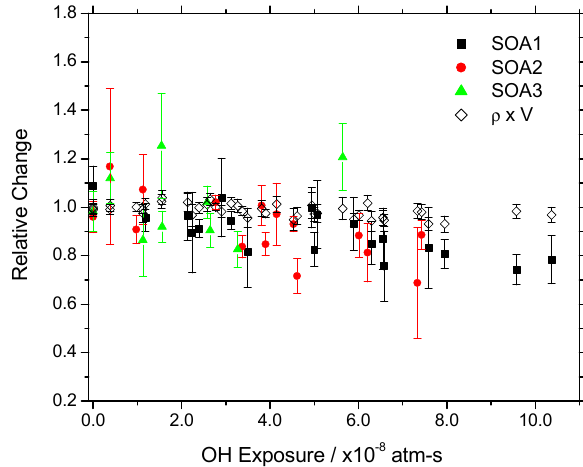
Fig. 7. Relative changes in volume and density with OH exposure for all SOA types.